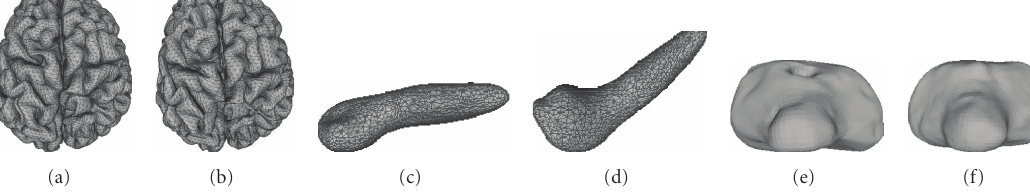
Figure 12: Reconstructed brain deformations using SRDS approach: (a) is the initial brain shape, (b)–(e) are the reconstructed brain de- formations.